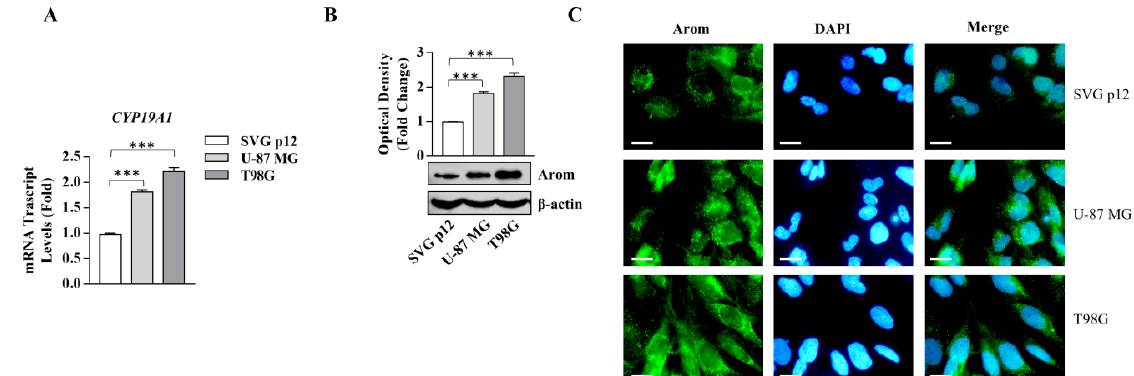
Figure 5. Aromatase expression in SVG p12 normal glial cells and U-87 MG and T98G glioblastoma cells. ( A ) Real-time RT-PCR for CYP19A1 in SVG p12 normal glial cells, U-87 MG, and T98G glioblastoma cells; mRNA is shown relative to SVG p12 normal glial cells. ( B ) Immunoblotting showing Arom protein expression. β-actin was used as a control for equal loading and transfer. The histograms represent the mean average ± SD of three separate experiments in which band inten- sities were evaluated in terms of optical density arbitrary unit and expressed as fold change over SVG p12 for U-87 MG and T98G. ( C ) Immunofluorescence of Arom in SVG p12 normal glial cells, U-87 MG, and T98G glioblastoma cells. DAPI staining for nuclear detection. Scale bars = 5 µm. Original magnification, ×100. Data are expressed as means ± SD of three different experiments, each performed in triplicate. *** p < 0.001.